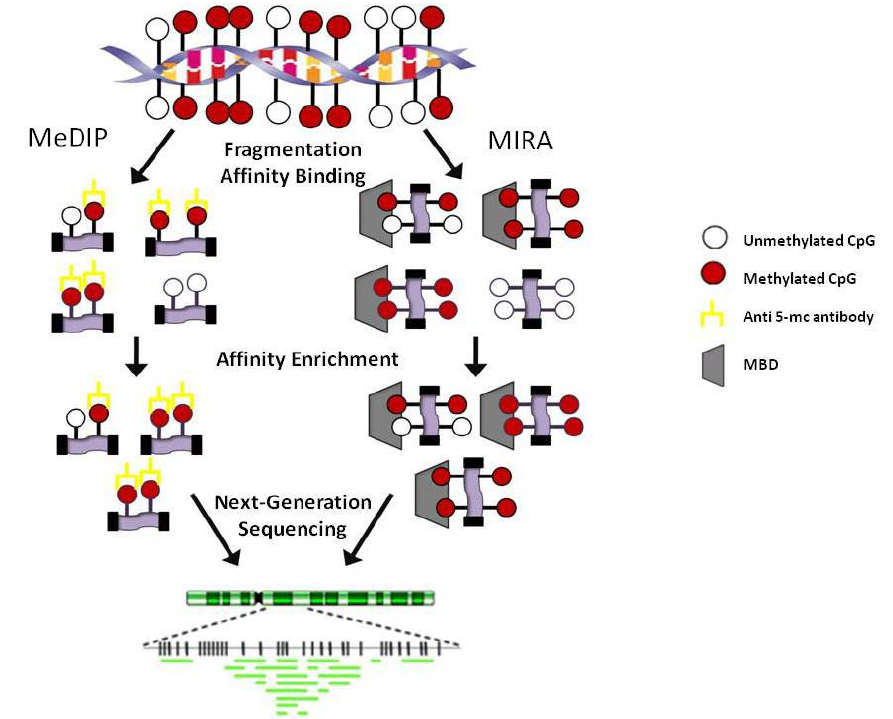
Figure 3. Affinity-based methodologies. MeDIP: Methylated DNA immunoprecipitation; MIRA: Methylated CGI recovery assay; MBD: Methyl-binding